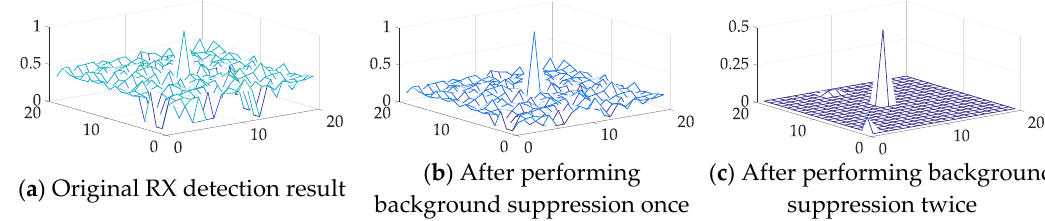
Figure 6. ( a ) 3-D visualization of the original RX detection result; ( b ) 3-D visualization of the result after one background restraint process; and ( c ) 3-D visualization of the result after two background restraint processes. The sub-pixel anomaly target has been gradually increased.